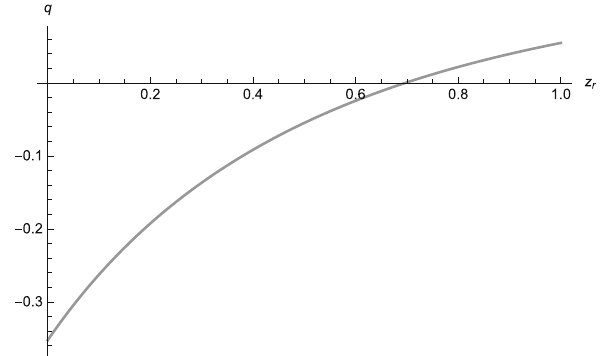
Fig. 29 The graphical nature of q ( z r ) over z r for the cosmological model associated with case III. The free parameters E 5 = 1 . 45, γ = 4 α = 4 > 3 and c = 0 . 0085, E = 0 . 0005 and E 2 1 4